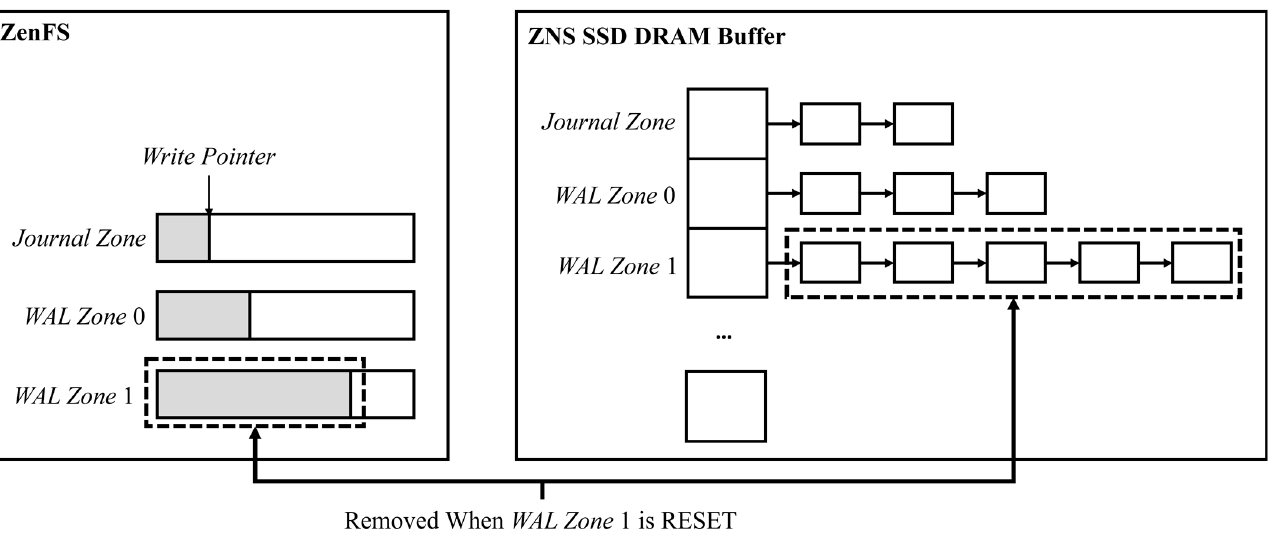
10 of 17 Figure 6. Buffer hit table and Buffer list for managing PLP and Non-PLP buffer. 4.4. ZenFS Modification for Selective-PLP To apply selective-PLP to ZenFS of RocksDB, we modified ZenFS as follows. First, zones are divided into two categories: durable zones and normal zones. Here, a durable zone indicates that data written into the zone should be guaranteed to be durable by using